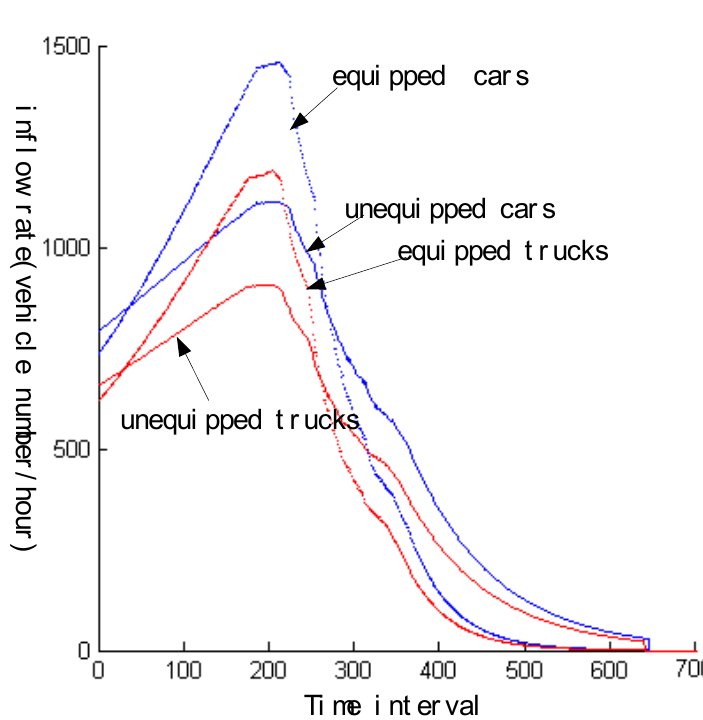
Figure 6. Link 2’s inflow rate of truck and car